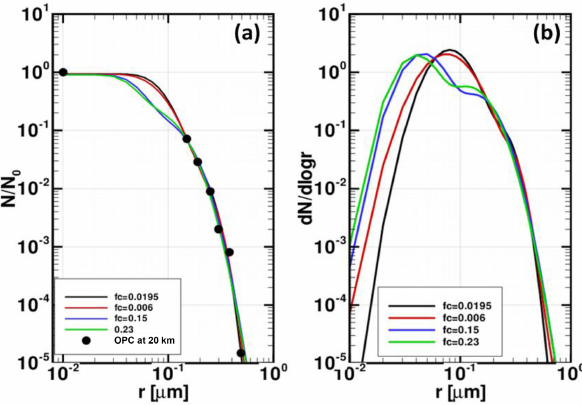
Figure A1. Estimated bimodal lognormal cumulative distribu- tions (a) and differential distributions (b) for nonvolcanic OPC measurement on 12 April 2000 at 20km (Kovilakam and Desh- ler, 2015). Measurements are shown as black dots on the left panel. Each fit with a different coarse-mode fraction, f c , which is the ratio of the number of particles of the coarse mode to the total number of particles for a bimodal lognormal distribution.